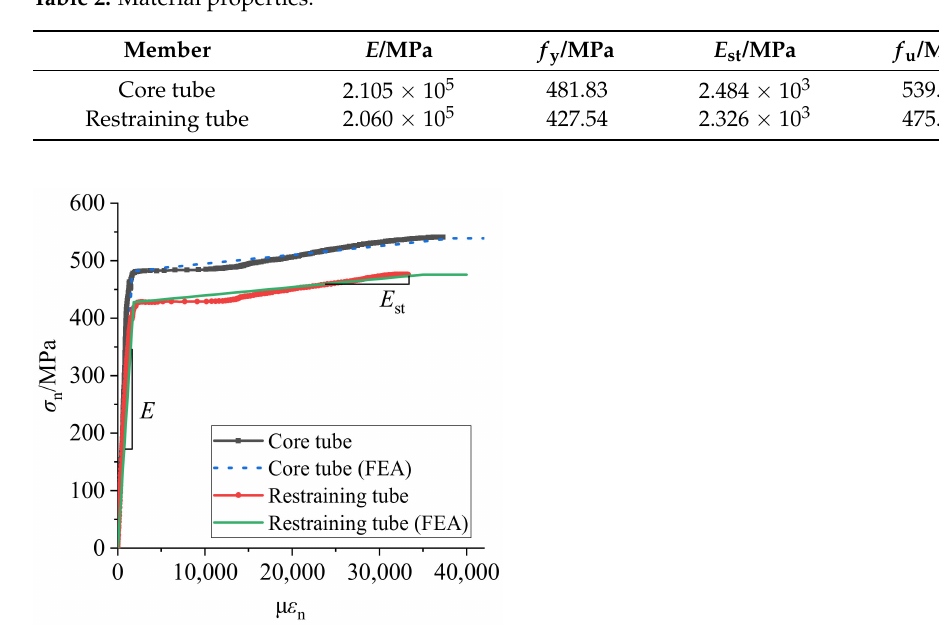
Figure 6. Stress versus strain relationships of the specimen.